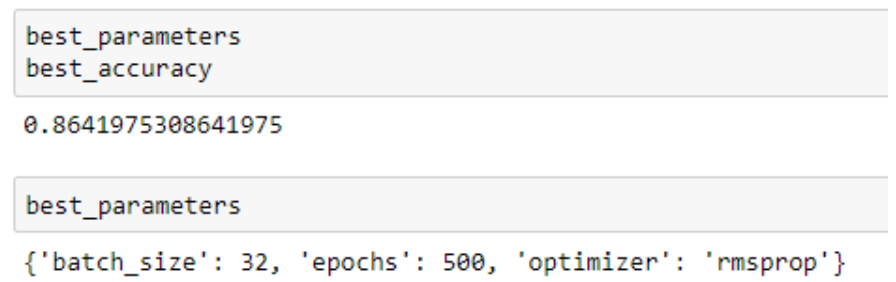
Figure 36. The best parameters with obtained after performing grid search with 10-Fold Cross-Validation on the ANN (3-6-6-1) model.